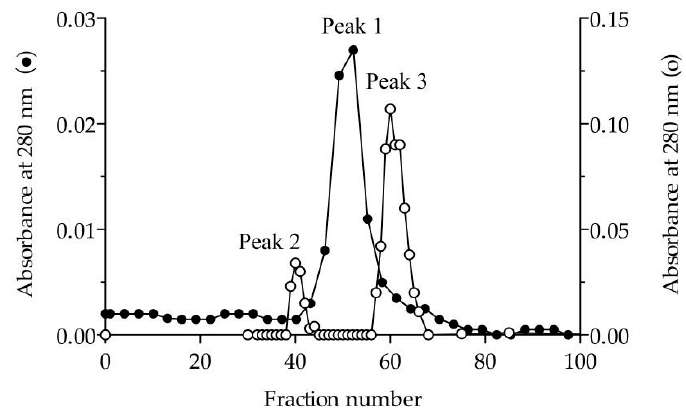
Figure 1. Elution profile in size-exclusion chromatography. Sephacryl S200 column (1.6×60 cm) equilibrated in 25 mM Tris-HCl (pH 7.5) containing 150 mM NaCl in the absence ( ● ) and presence ( ○ ) of 1% ( w / v ) sodium cholate. Peak 1 corresponds to dimeric Lip3 (117 kDa). Peak 2 and peak 3 correspond to a high molecular weight lipase-cholate aggregate and monomeric Lip3 (60 kDa), respectively. Loaded sample: Dimeric Lip3. Flow: 0.3 mL/min. Fractions: 3 mL.